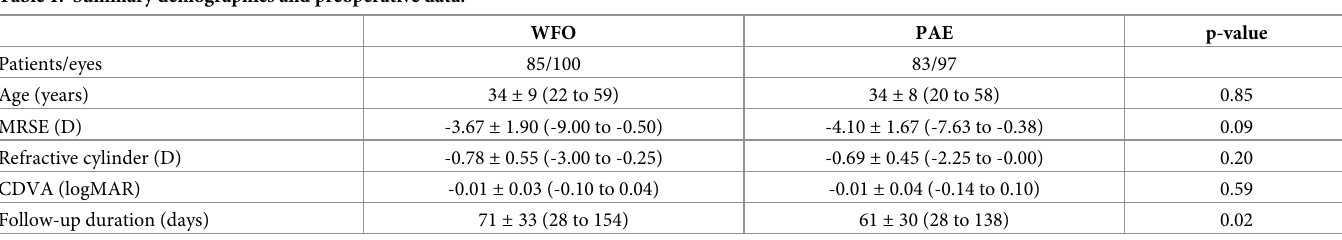
Table 1. Summary demographics and preoperative data.